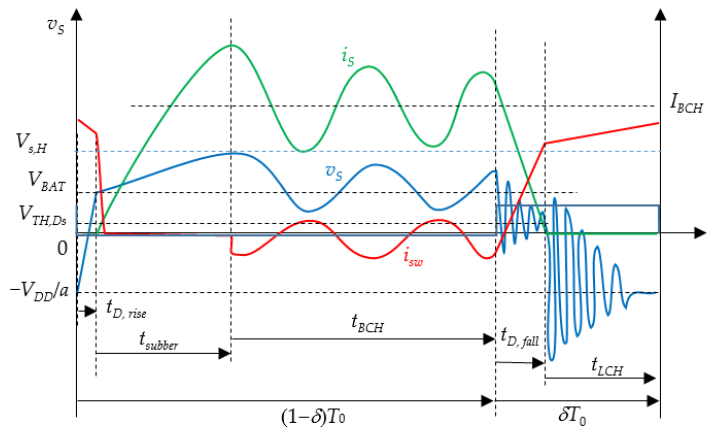
Figure 1. Flyback converter circuit.